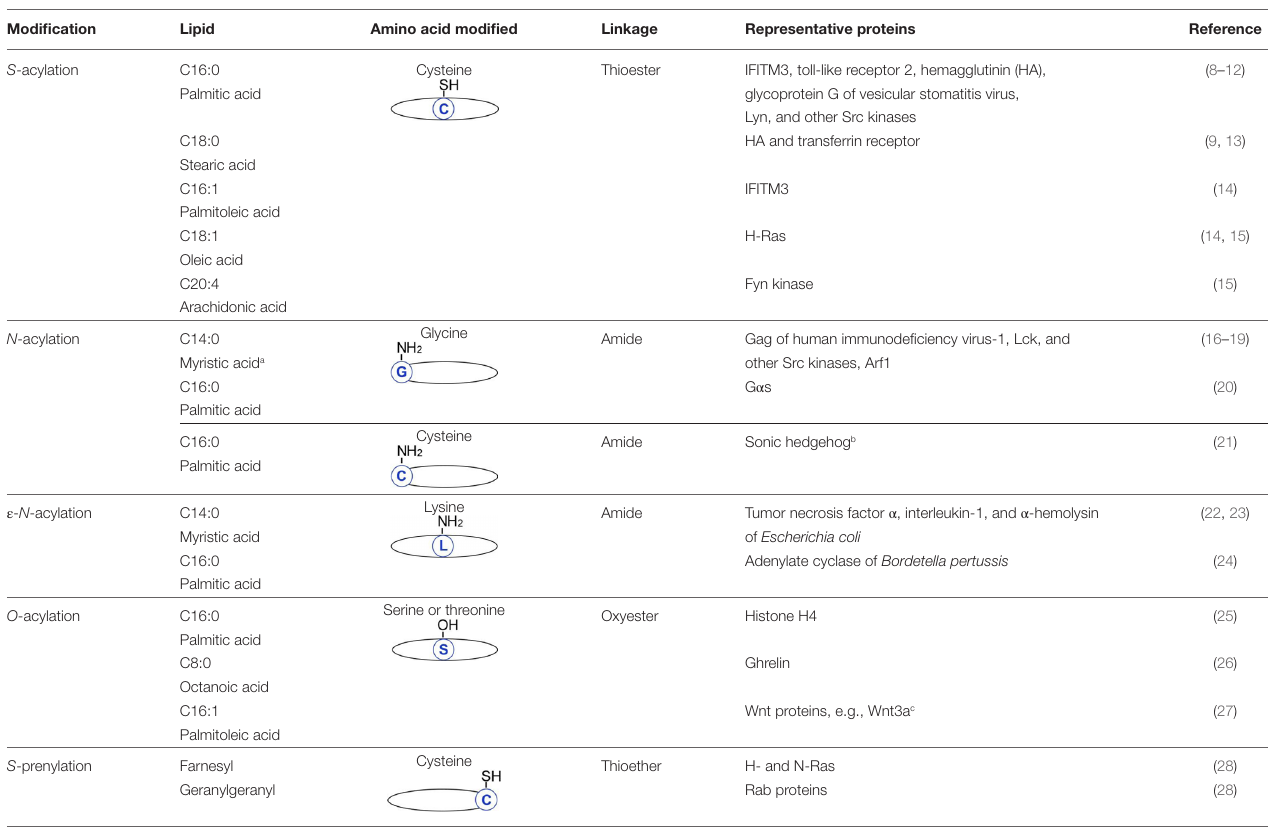
TaBle 1 | Fatty acylation and prenylation of